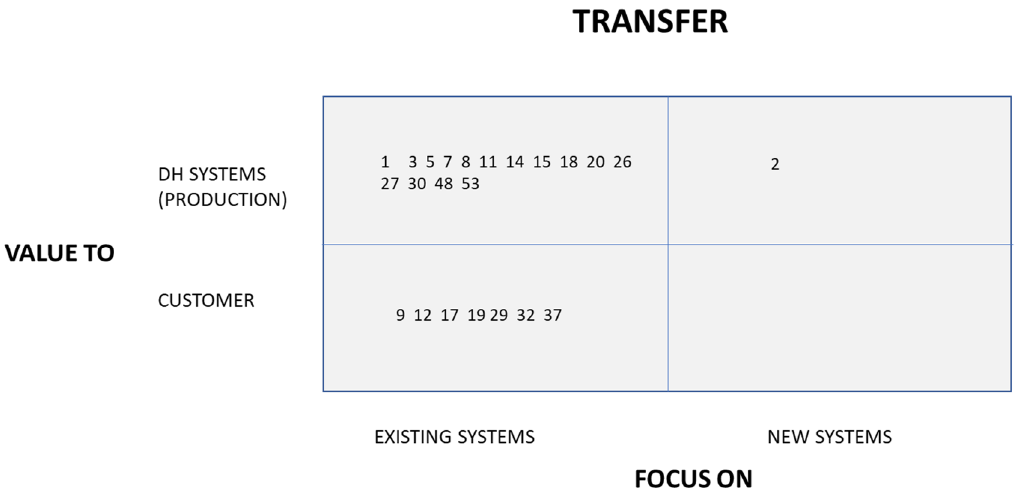
Figure 12. Articles from the three groups that arose from further analysis of P2. The analysis was in two more dimensions: the value, which was primarily based on the customer or to the DH system (production); and focus, looking at whether they were new systems or existing systems. Each article is numbered, where the lowest number corresponds to the highest citation rate, as in the previous figure.